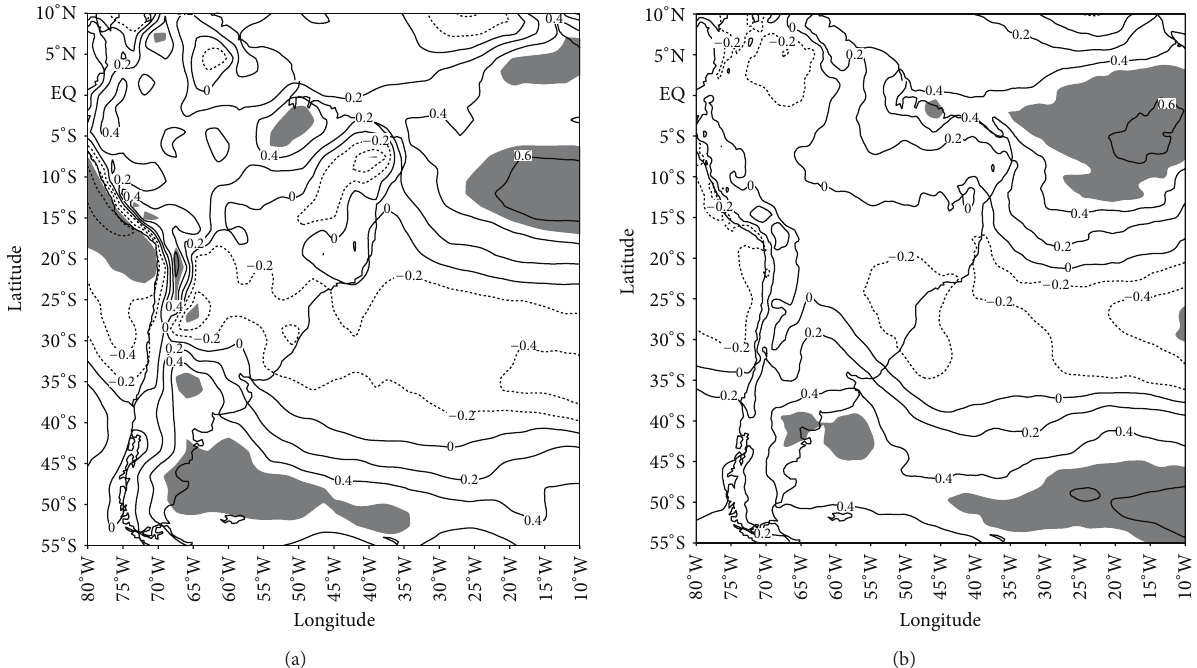
Figure 18: Correlation between the HCSA annual poleward edge time series and the annual mean temperature (K) at 925 hPa in the period 1996–2011 based on the (a) Era-Interim reanalysis and (b) RegCM4 simulation. Contour intervals are 0.2 and values above 0.5 are shaded and are statistically significant at 95% confidence level. Here, the poleward edge is defined as the latitude where the OLR is equal to 240 Wm −2 . For clarity purposes, it should be noted that the HCSA annual poleward edge time series have been multiplied by ( − 1).